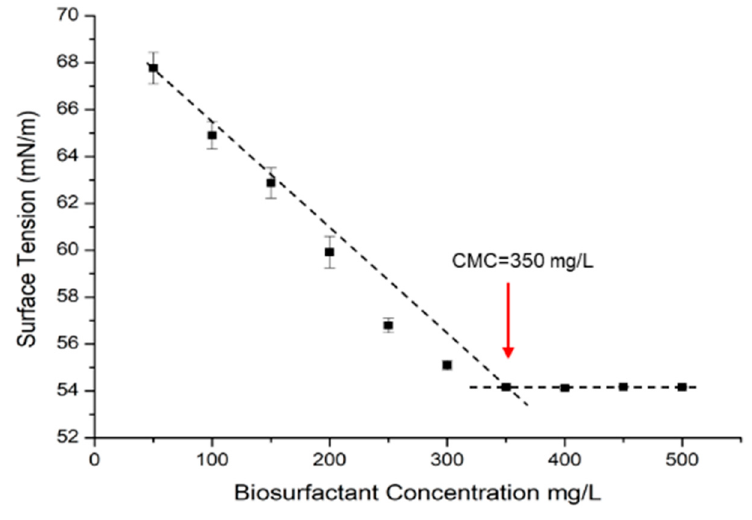
Figure 7. Critical micelle concentration (CMC) and minimum surface tension reduction by crude biosurfactant produced by H. meridiana BK-AB4 at 36 °C.